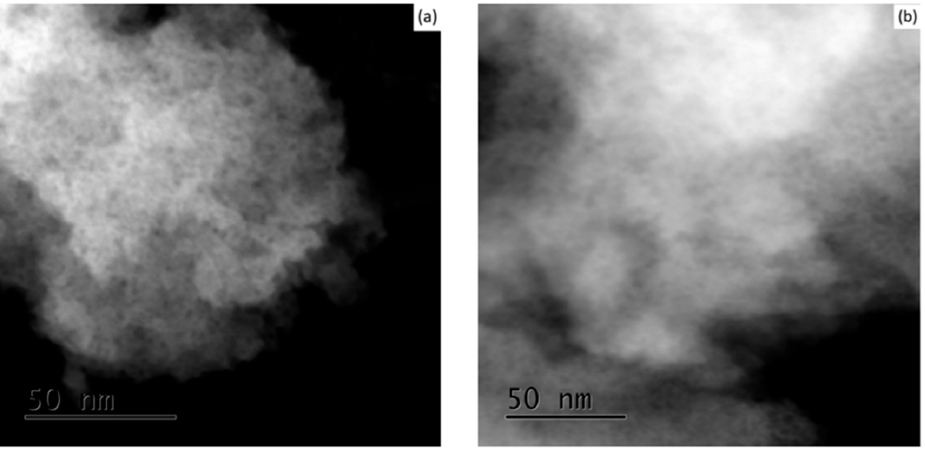
Figure 5. TEM images of 8 YSZ ( a ) and 7 YSZ ( b ) before calcination for contact drying method.